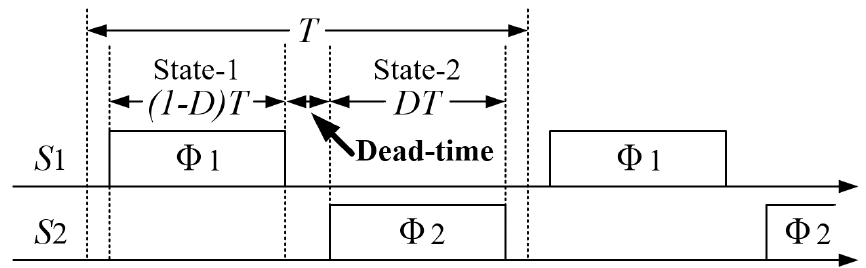
Figure 2. PWM signals for operation of CCFSCC.